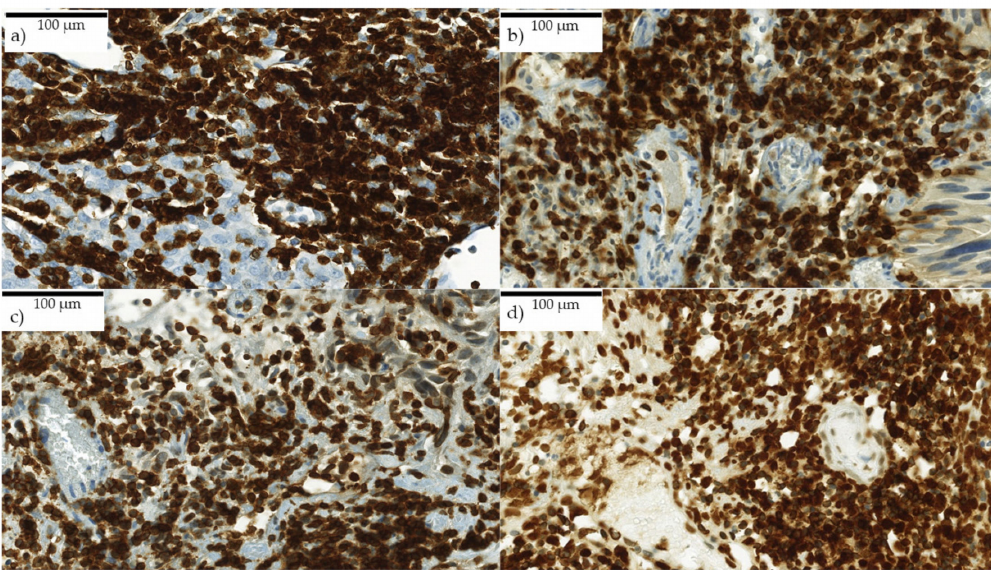
Figure 5. ( a – d ) Very high immune reaction in CD3 + stained slides. Each picture shows one HPF in the stroma. Cells were displayed superimposed. Exact di ff erentiation of single cells was not possible for the program. Scanned with digital slide scanner (camera: CIS VCC, Panoramic MIDI Scan; 3DHistech Ltd., Budapest,